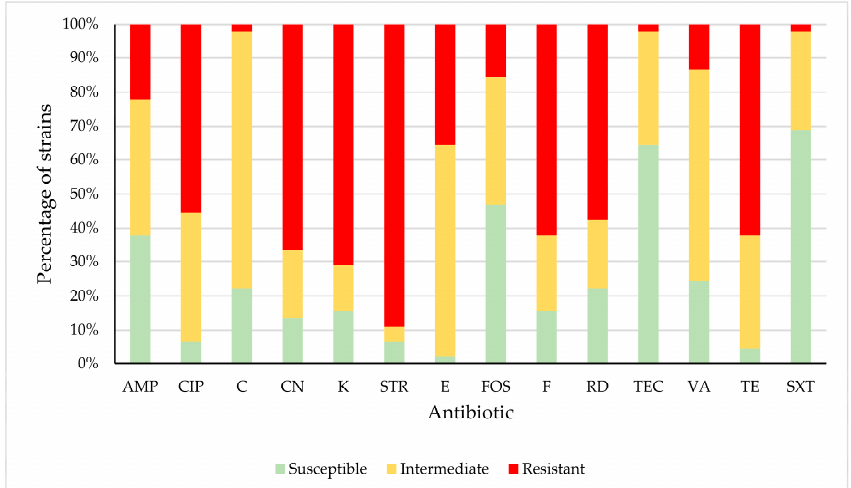
Figure 3. Percentage of Enterococcus faecalis strains susceptible, intermediate or resistant to each antibiotic tested. Ampicillin (AMP); ciprofloxacin (CIP); chloramphenicol (C); gentamicin (CN); kanamycin (K); streptomycin (STR); erythromycin (E); fosfomycin (FOS); nitrofurantoin (F); rifampicin (RD); teicoplanin (TEC); vancomycin (VA), tetracycline (TE); trimethoprim-sulfamethoxazole